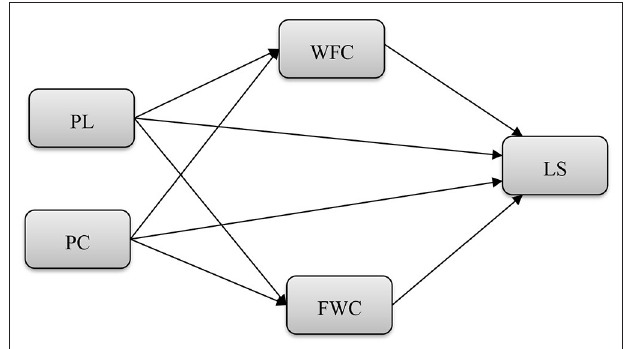
FIGURE 1 | Study framework. PL, paternalistic leadership; PC, polychronicity; WFC, work-family conflict; FWC, family-work conflict; LS, life